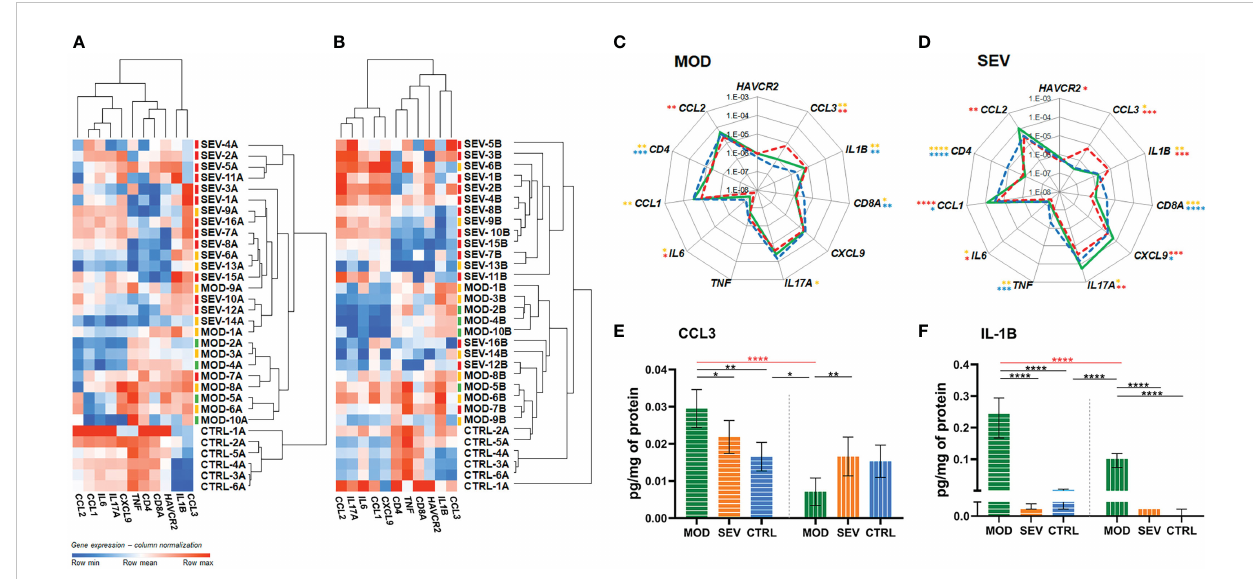
FIGURE 3 Vitamin B12 favorably modulated critical in fl ammatory mediators. (A, B) : Dendrogram and heatmap depicting the hierarchical clustering and expression levels of COVID-19 hyperin fl ammation-related genes panel in whole blood cultures of untreated MOD and SEV patients (endpoint A) (Panel A) or treated with B12 (endpoint B) (Panel B) and untreated non-infected controls (endpoint A). Colored dashes next to the sample identi fi cation correspond to the patient ’ s outcome. Green dashes: patients discharged from hospital one day after sample collection; Yellow lines: patients discharged from hospital two or more days after sample collection; Red lines: patients died. ( C, D) : Radar charts depicting the expression levels of COVID-19 hyperin fl ammation-related genes panel in whole blood cultures. The fi lled green lines correspond to gene expression values of infected groups (MOD, Panel C or SEV, Panel D) at endpoint (B) Dashed red lines correspond to gene expression values of infected groups at endpoint (A) Dashed blue lines correspond to gene expression values control group at endpoint (A) The gene expression values (2e(- D Ct)) of the groups were compared pairwise using two-tailed Student ’ s t, paired Student ’ s t, Mann-Whitney and Wilcoxon tests according to experimental design and data distribution. Values were expressed as medians. N sample = MOD (10) and SEV (16) for each endpoint (A or B) , CTRL (6). Yellow asterisks